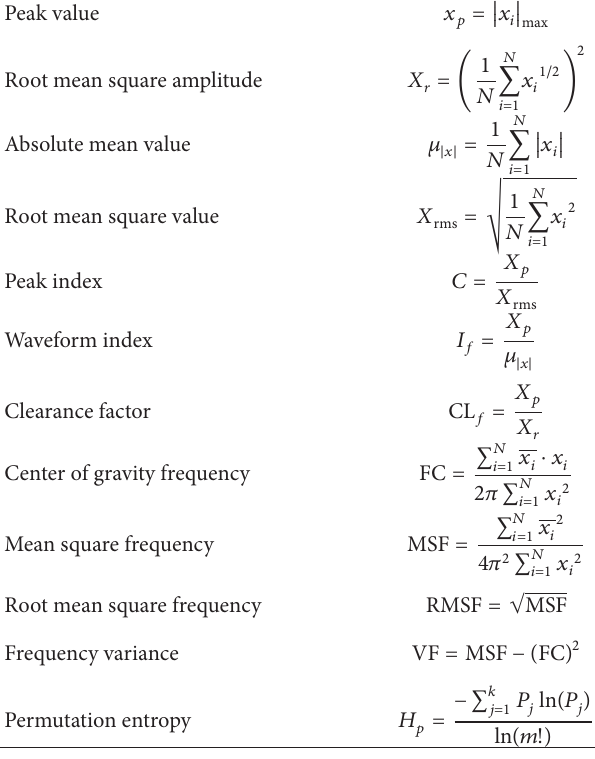
Table 1: Hybrid domain